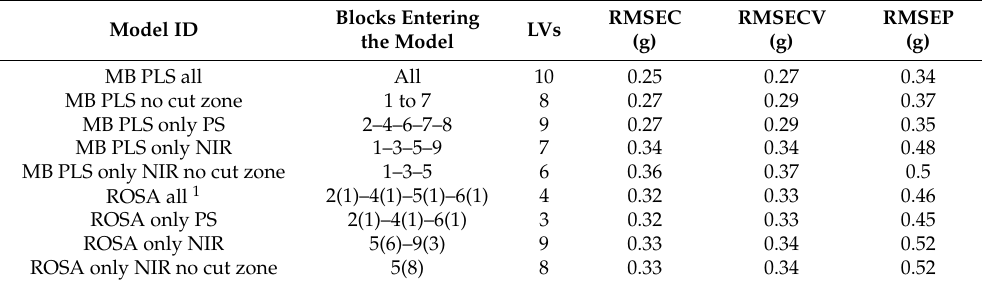
Table 3. Results yielded by MB-PLS and ROSA for the prediction of Property 2. Model